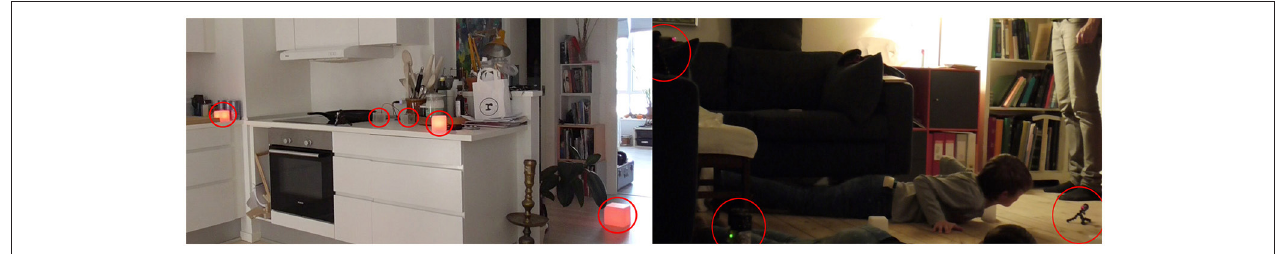
FIGURE 2 | Two different set-ups: on the left; the light and music cubes involving the kitchen table, and to the right: the laser field involves the sofa in the living room.